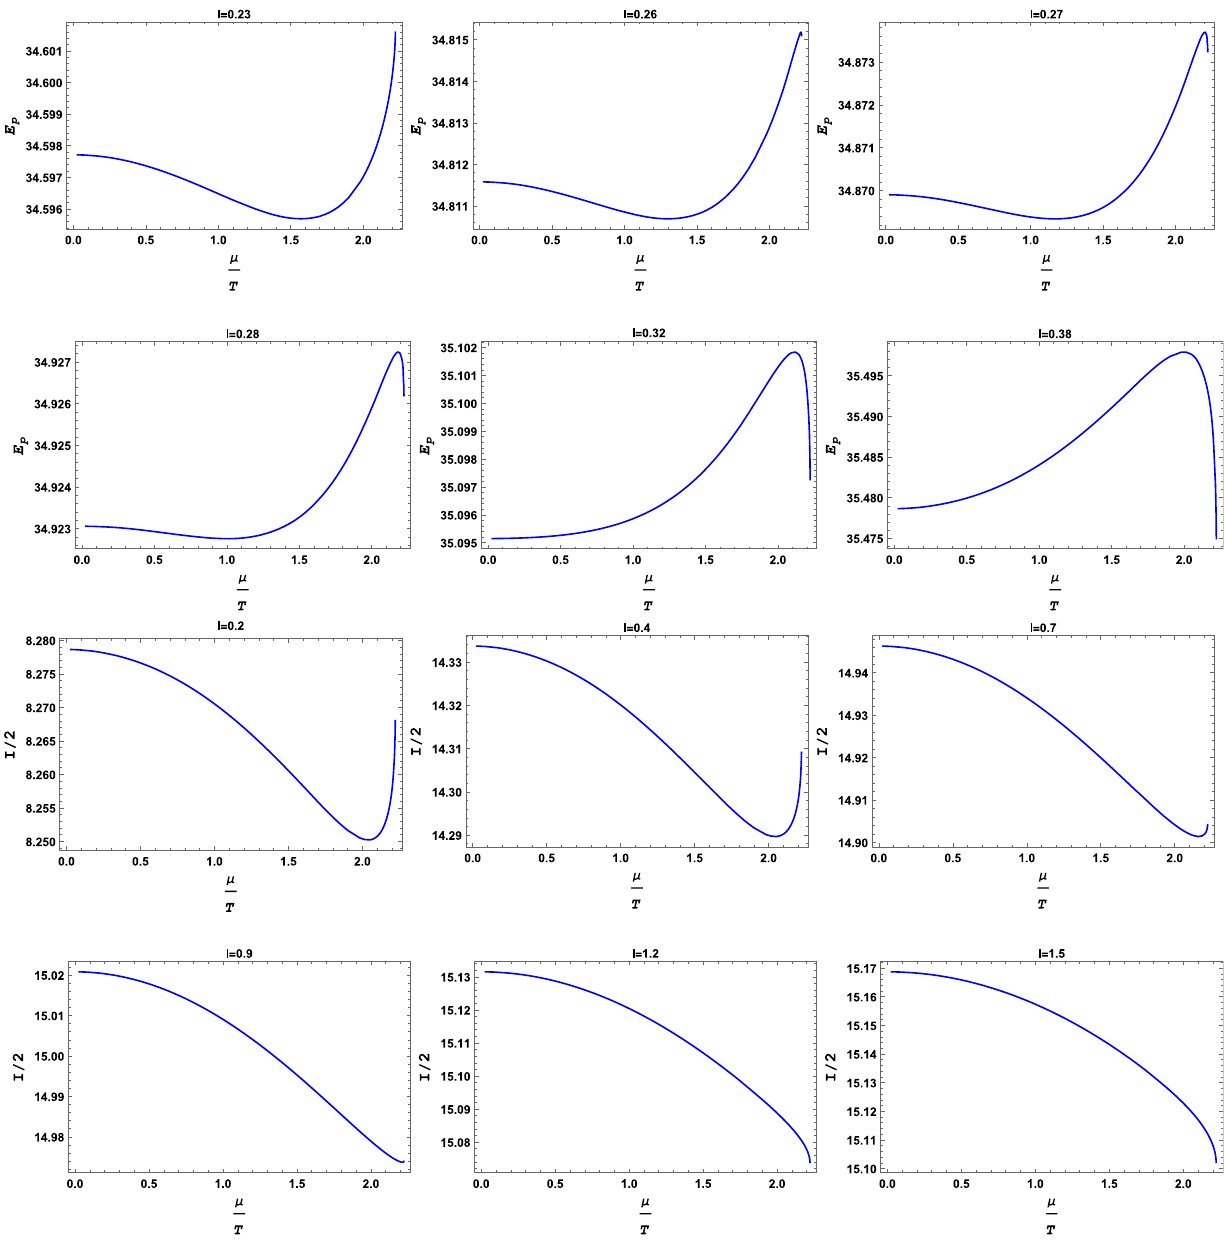
for l (cid:3) = 0 . 1. The two lower rows: half of the mutual information, I T